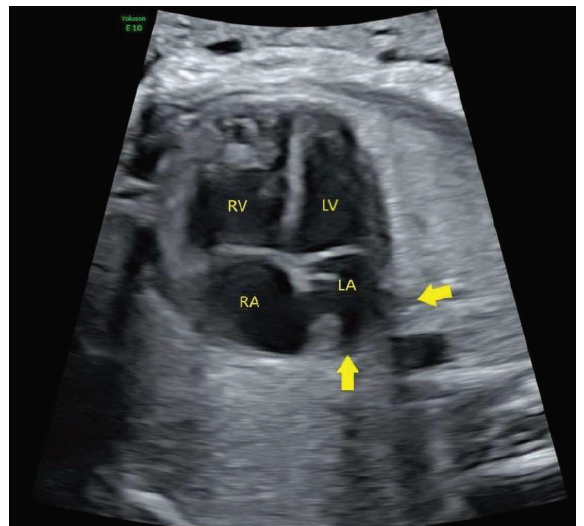
Figure 1: Standard 2D greyscale ultrasound image of the 4- chamber view of the fetal heart with pulmonary vein entry into the left atrium (LA) indicated by yellow arrows (legend: LA � left atrium, RA � right atrium, LV � left ventricle, and RV � right ventricle.).